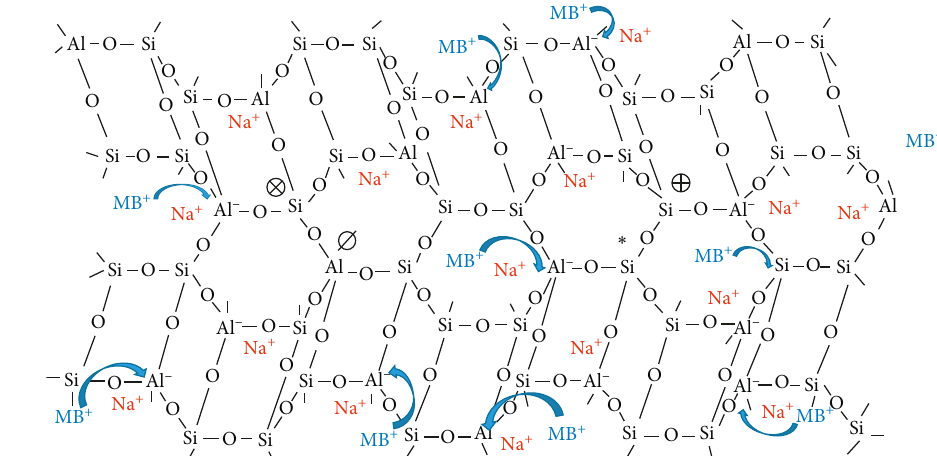
Figure 8: Proposed mechanism for adsorption of methylene blue by geopolymer.